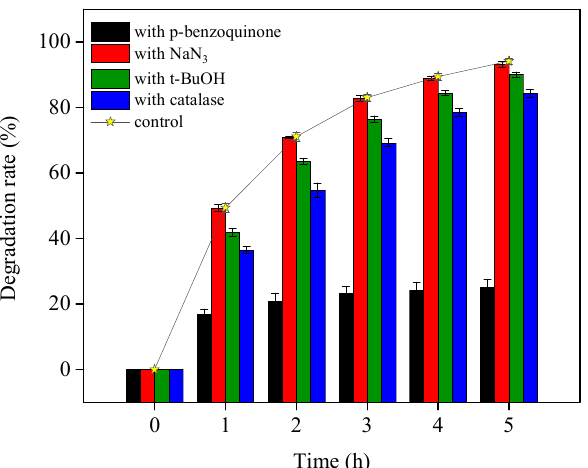
Figure 5. TiO 2 -assisted photosensitized OTC degradation with the addition of different ROS scav- engers under visible light irradiation at pH 8.6. Experimental conditions: [OTC] 0 = 10 mg L − 1 , [NaN 3 ] 0 = 5 mM, [t-BuOH] 0 = 10 mM, [ p -benzoquinone] 0 = 5 mM, [catalase] 0 = 12 unit L − 1 , 50 mM phosphate